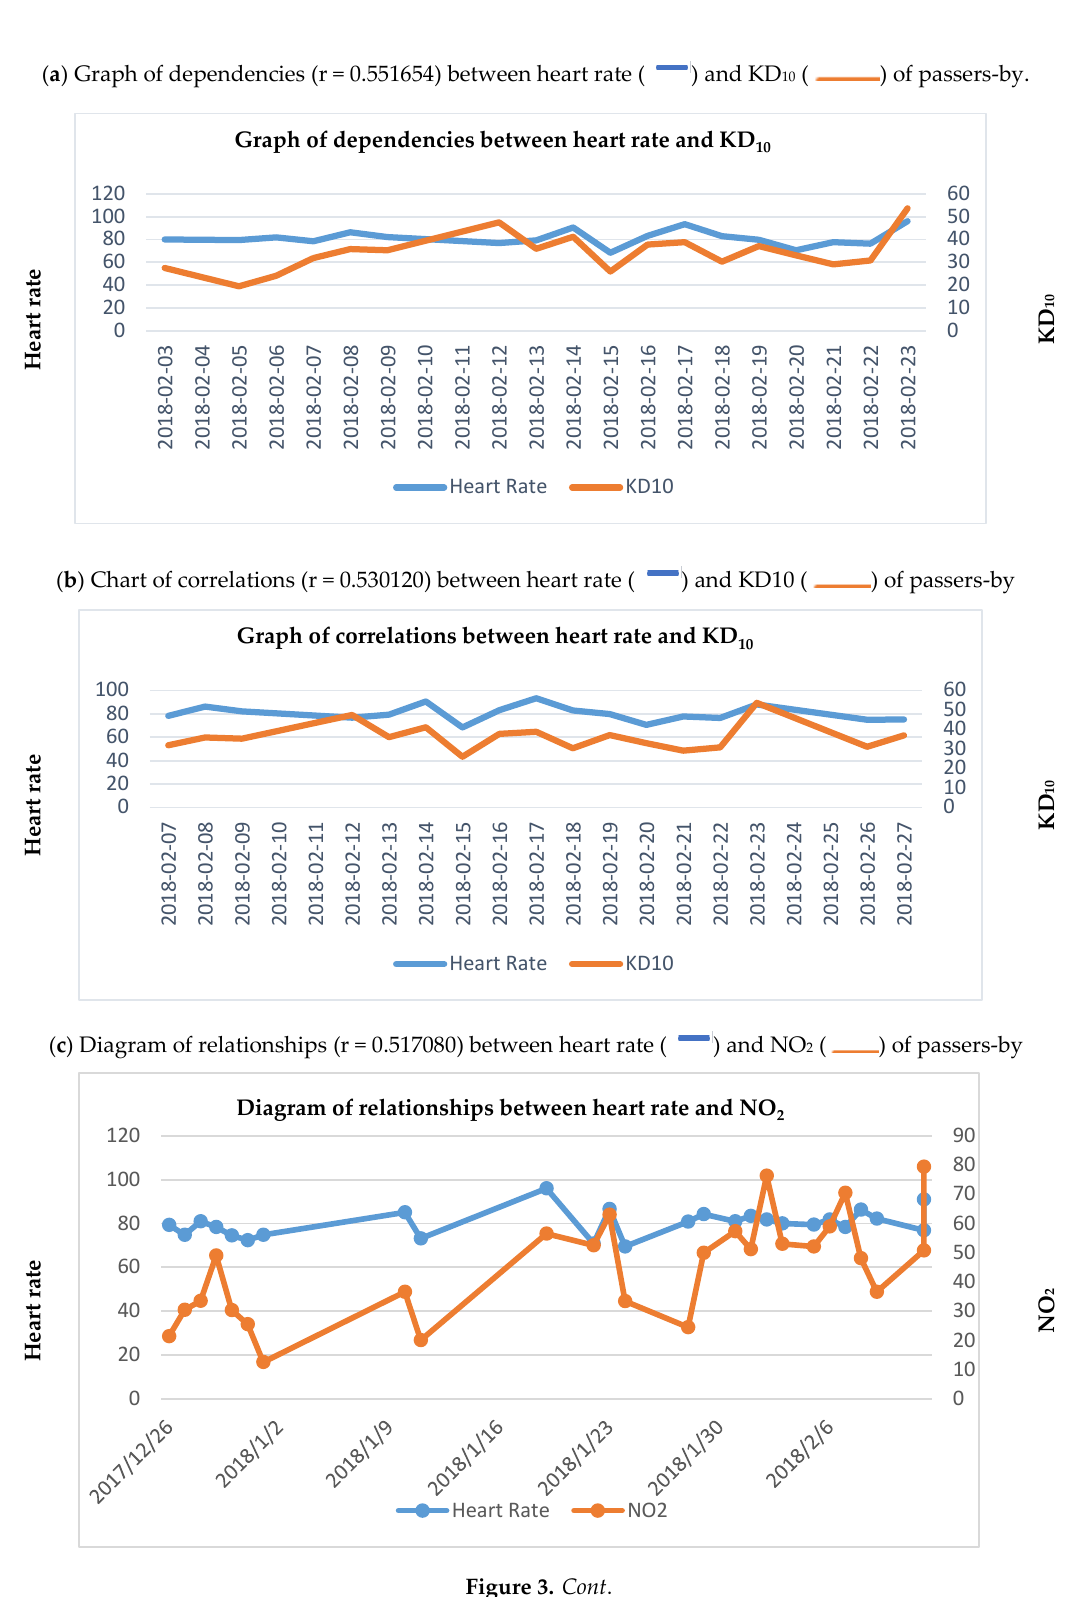
Heart Rate NO2 Figure 3. Cont